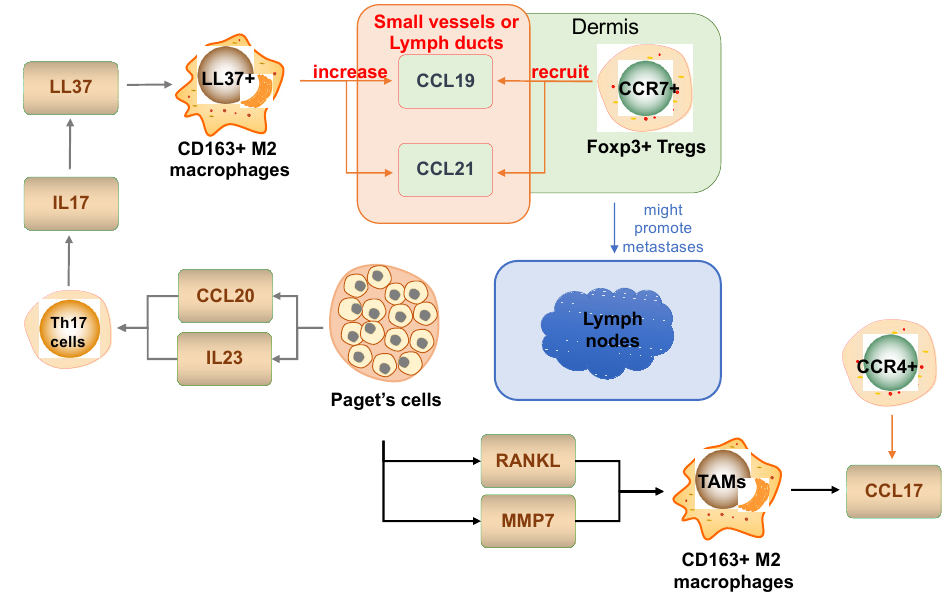
Figure 2. Schematic representation of TAMs in the EMPD tumor microenvironment .